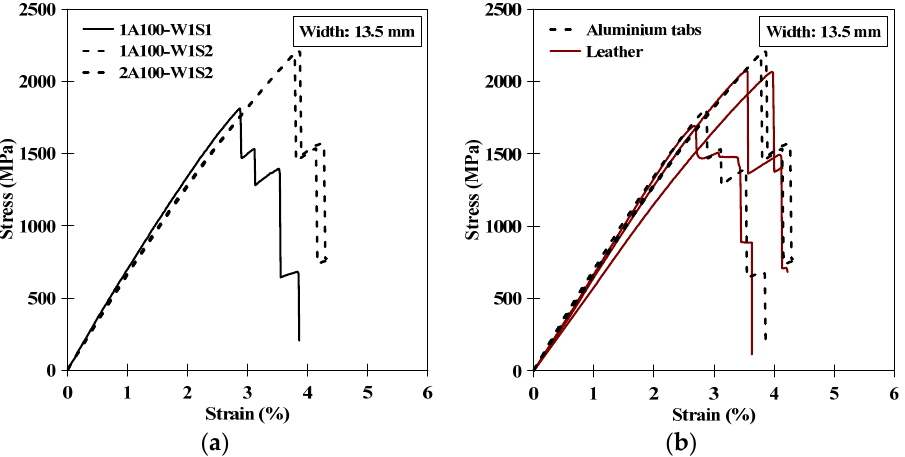
Figure 14. Stress–strain results of the specimens equipped with aluminium tabs at the ends: ( a ) set width and variable displacement rate and ( b ) comparison between the results of the strips equipped with aluminium tabs and leather pieces.